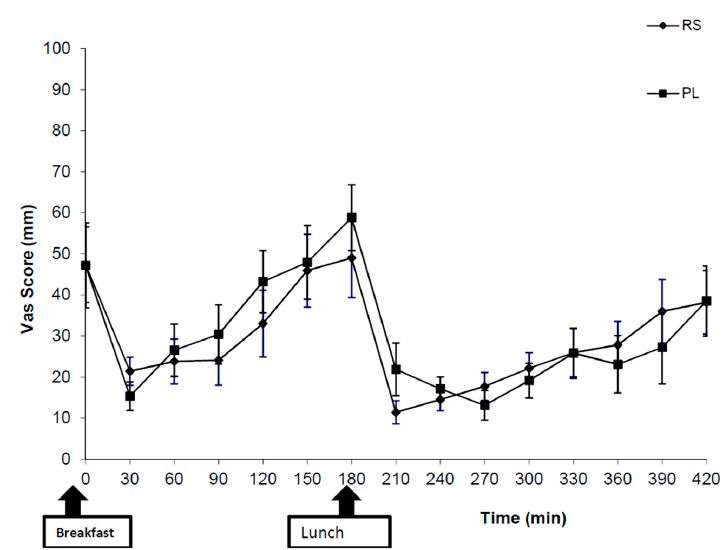
Figure 1. Subjective appetite ratings in response to the question “how hungry do you feel?” after consumption of 48 g of resistant starch (RS) or placebo (PL). The values represent means ± SEM ( n = 10).